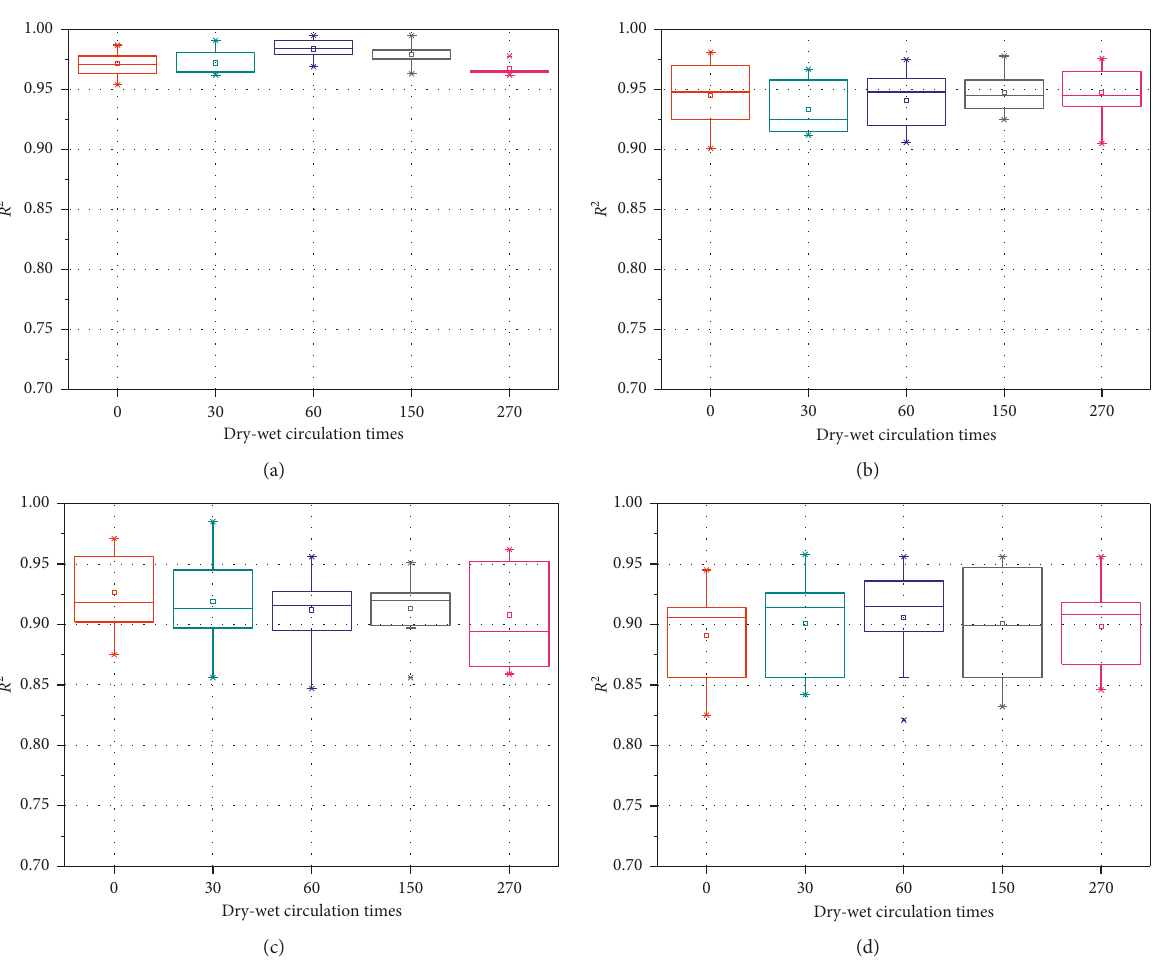
Figure 5: Percentile box figure with the analysis index of R 2 for (a) the double exponential model, (b) the Weibull model, (c) the first-order process, and (d) the zero-order